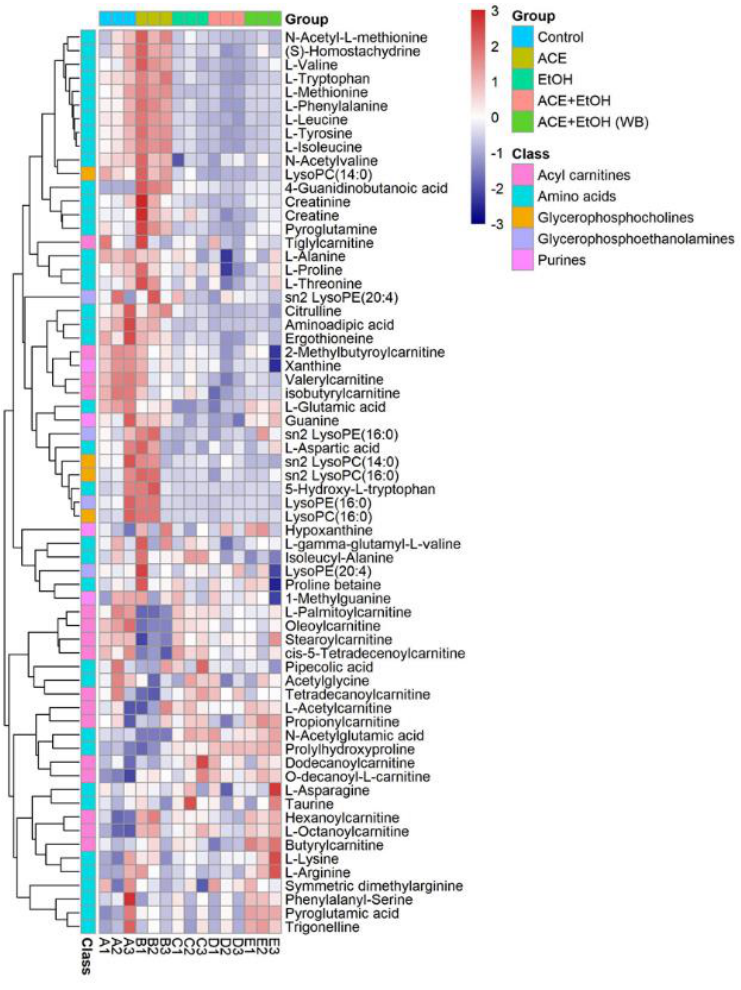
Figure 8. Clustered heatmap of L-02 metabolites.